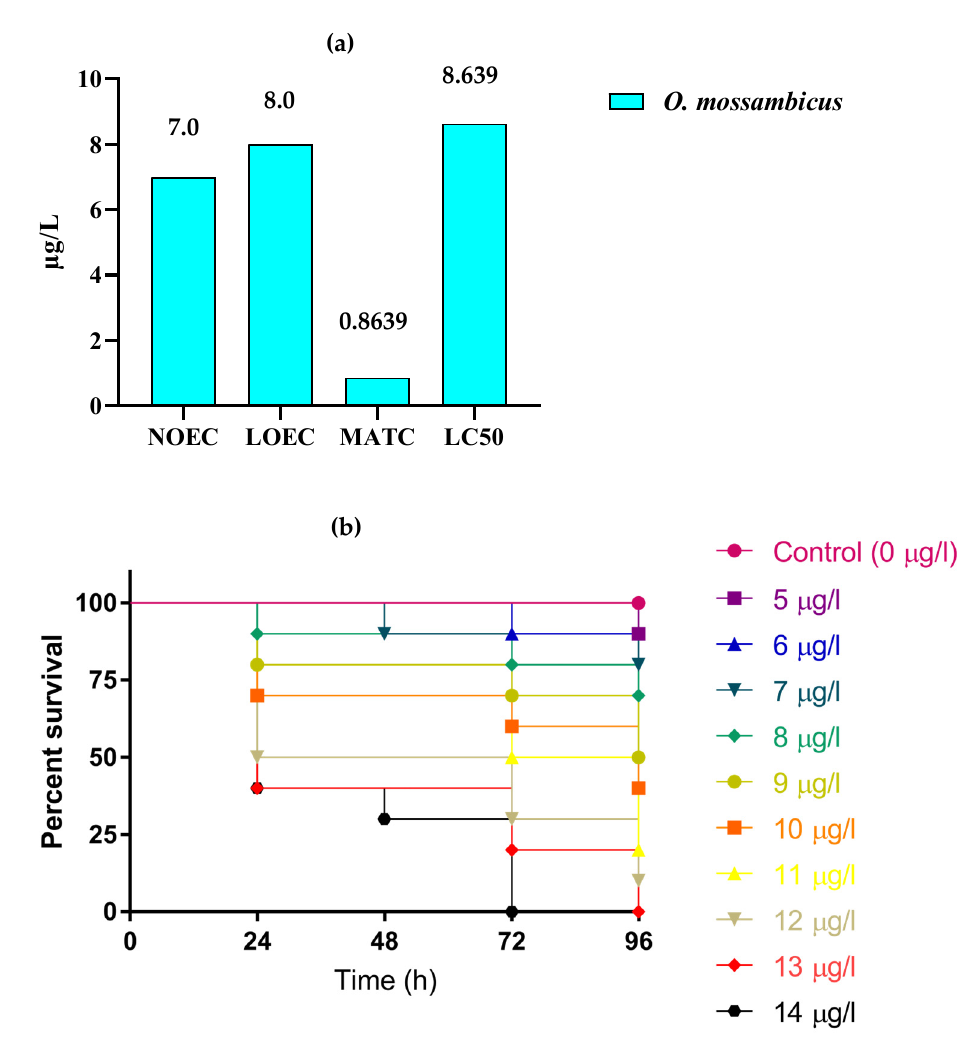
Figure 1. ( a ) Figure 1. NOEC and LOEC (after 24 h); MATC and LC 50 value (after 96 h) for O. mossambicus exposed to deltamethrin. ( b ) Kaplan–Meier survival curves of O. mossambicus exposed to various exposure concentrations of deltamethrin (log-rank (Mantel-Cox) test: Chi square-88.14; df 10; p value: < 0.0001). Table 1. Lethal concentrations (LC 10, 20, 50 ) plus 95% fiducial limits [given in square brackets] of deltamethrin to O. mossambicus at 24 h–96 h exposure (ten fish per aquarium, forty fish per exposure group; four replicates).